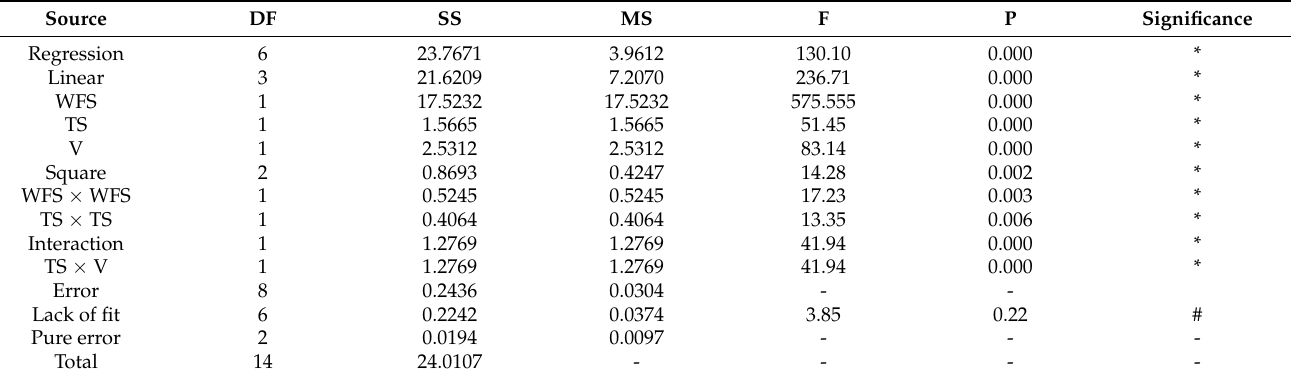
Table 4. ANOVA for bead width